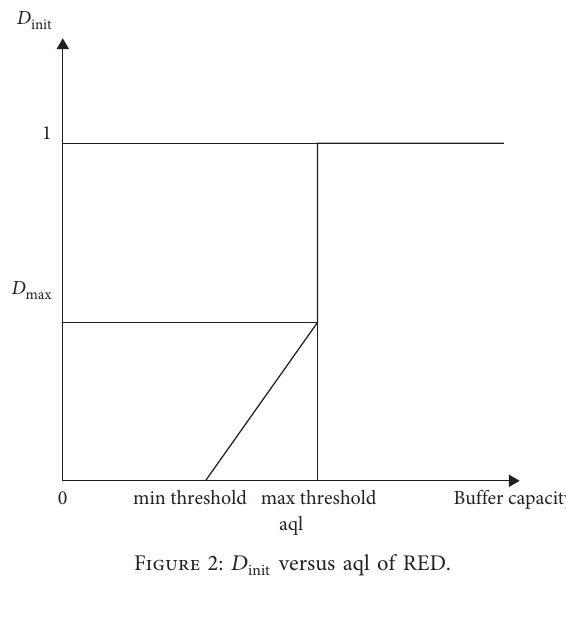
versus aql of init